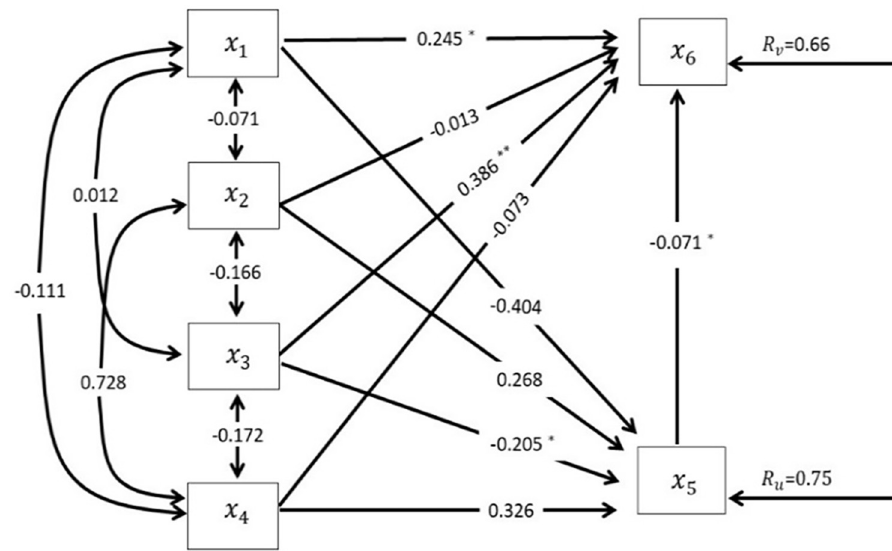
Fig 2. Path diagram of factors affecting LE. p � < 0.05 and p �� < 0.01.